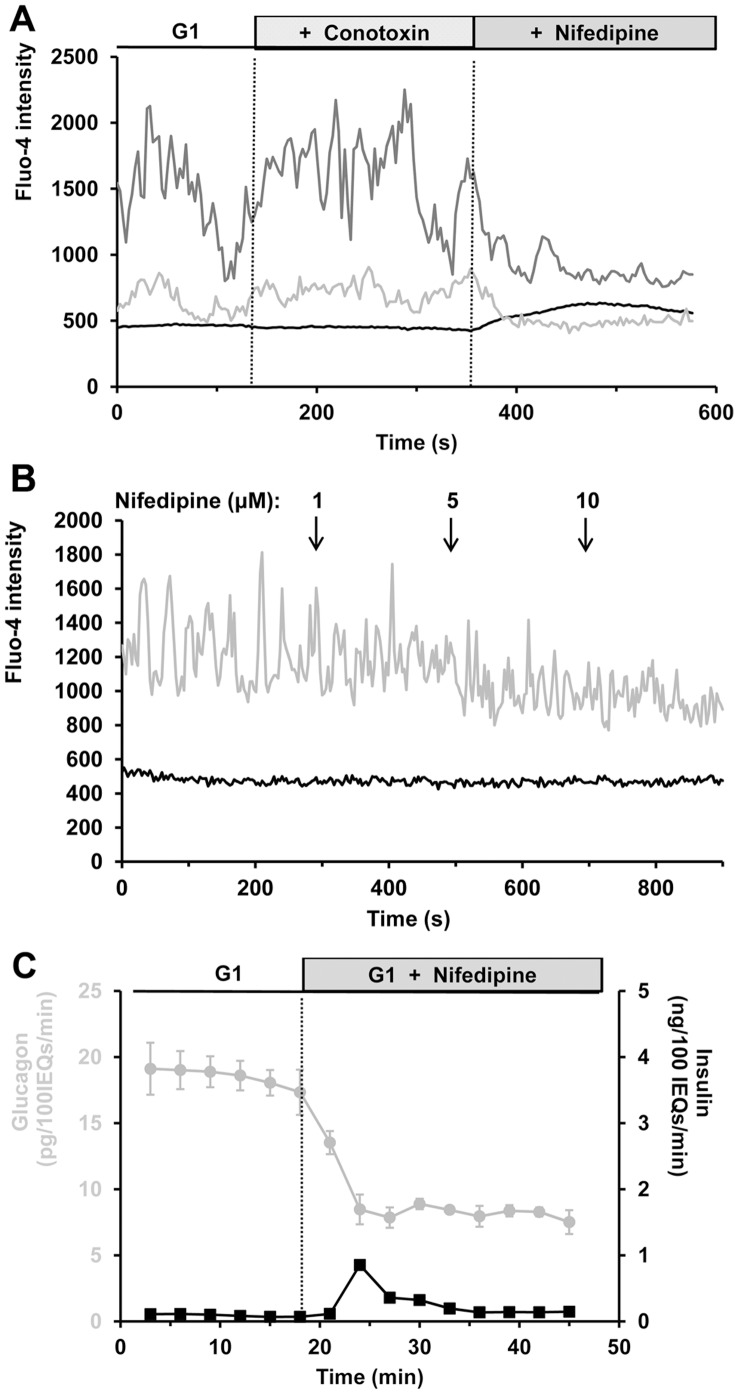
Effects of high-voltage-gated calcium channel inactivation on islet [Ca2+]i and hormone secretion.A, representative intracellular calcium responses to blockade of N- and L-type calcium channels. Gray traces represent α-cell [Ca2+]i, and black traces indicate β-cell [Ca2+]i. Fluo-4 intensity is expressed in arbitrary units. Calcium responses from two α-cells in the same islet are shown. N- and L-type channel inhibitors (1 µM ω-conotoxin and 20 µM nifedipine, respectively) were perifused. The figure is representative of 15 α-cells from 5 islets isolated from 3 mice. B, increasing concentrations of nifedipine were perifused at times indicated by the arrows. Nifedipine (≤ 10 µM) reduces calcium activity in α-cells without affecting β-cell [Ca2+]i. The figure is representative of 10 α-cells from 3 islets harvested from 3 mice. C, effects of nifedipine on hormone secretion from intact perifused islets. Islets were exposed to 1 mM glucose for 30 minutes (from −30 to 0 min). Glucagon and insulin responses (gray and black traces, respectively) were measured for 15 minutes at 1 mM glucose (G1), and 20 µM nifedipine was added to the perifusion medium for 30 minutes. Experiment was repeated 4 times, 600 islets from 8 mice were used. Error bars represent the standard error of the mean.